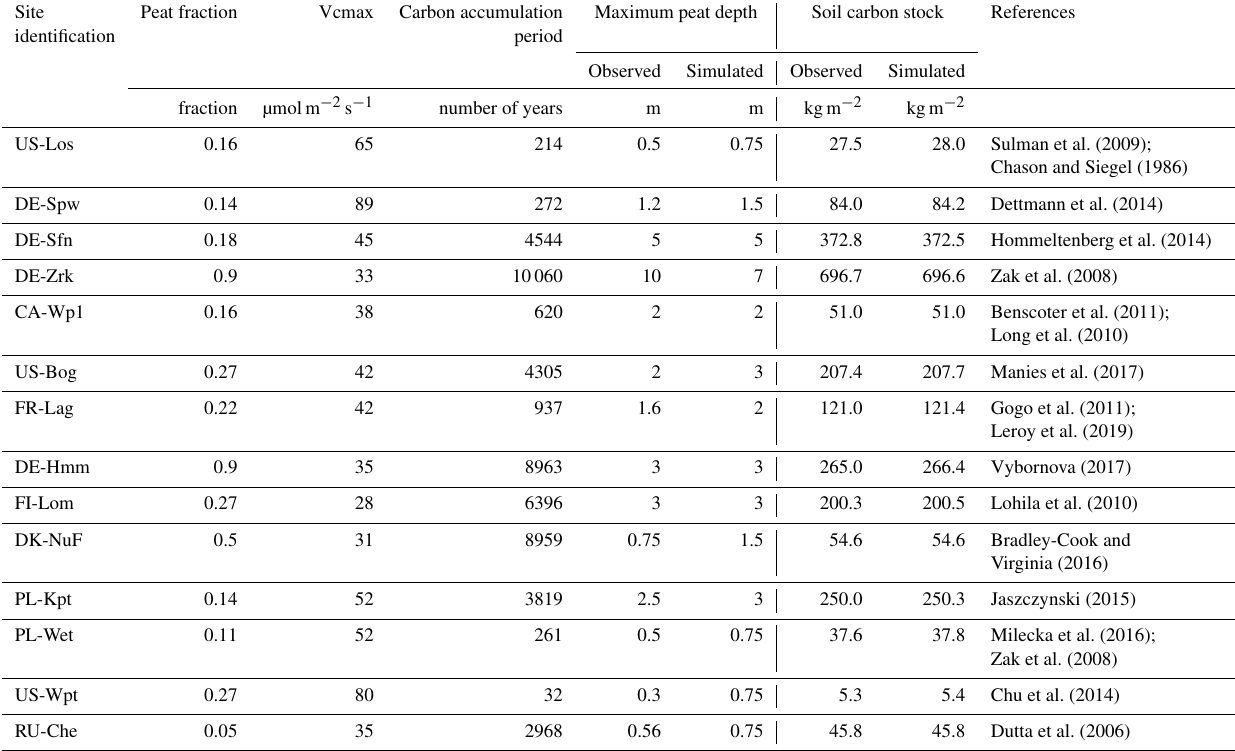
Table 2. Simulation conditions and framework to constrain peatland soil carbon stocks. Site